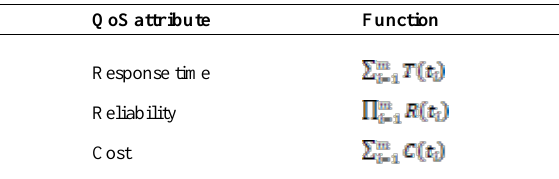
Table 1. Estimation function of the consensus values of QoS